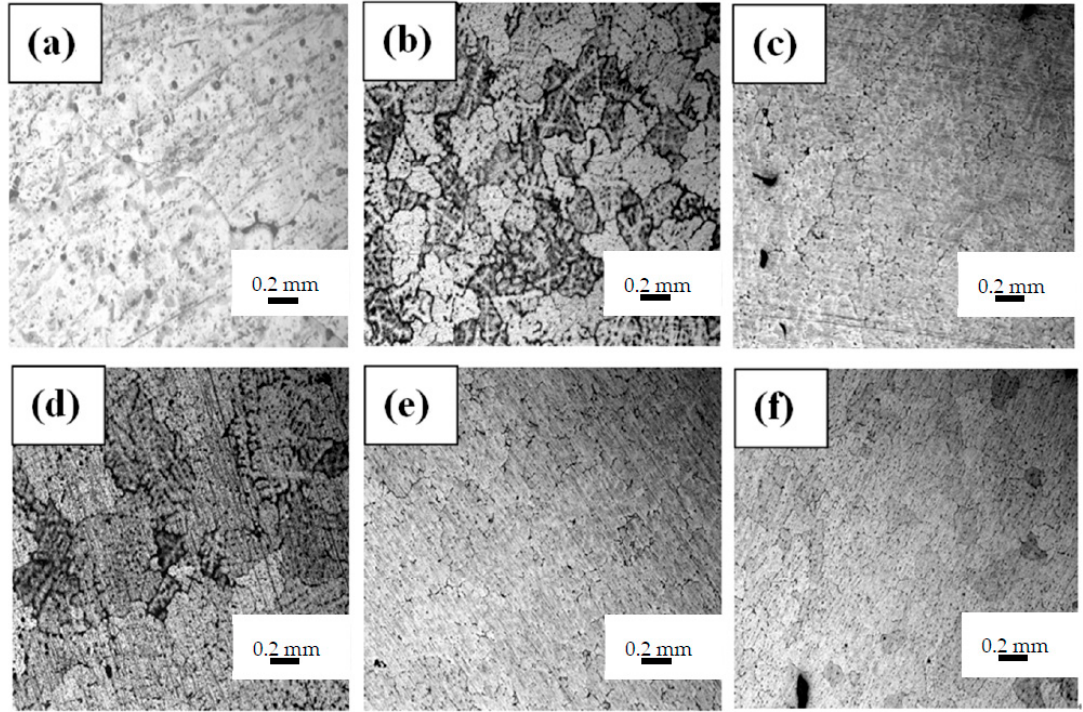
Figure 1. Microstructures of the cast Al base alloy samples with different Ga percentages: ( a ) 0, ( b ) 0.01 wt%, ( c ) 0.02 wt%, ( d ) 0.03 wt%, ( e ) 0.04 wt% and ( f ) 0.05